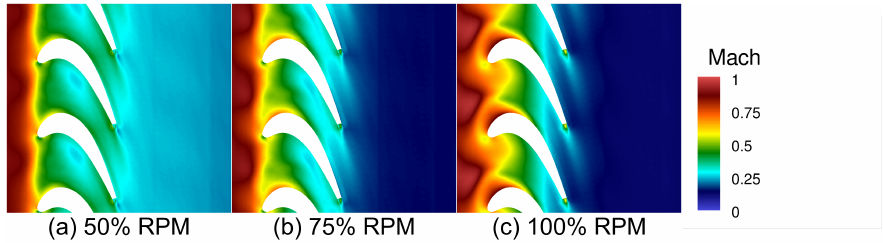
Figure 20. Mean Mach number contours near the stator–rotor region at 50% span location of the rotor blade for: ( a ) 50% RPM; ( b ) 75% RPM; and ( c ) 100% RPM.